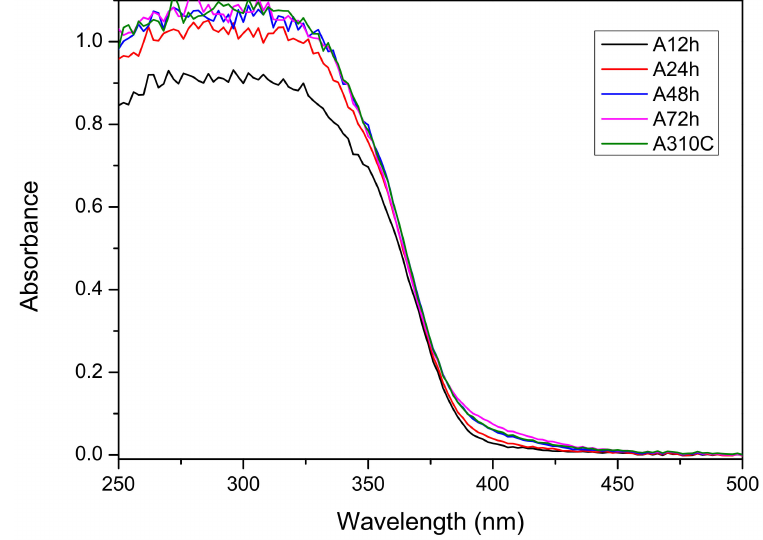
Figure 4. Di ff use reflectance UV-Vis spectra of TiO 2 NPs treated hydrothermally for 12 h, 24 h, 48 h, and 72 h at 250 ◦ C and at 310 ◦ C for 24